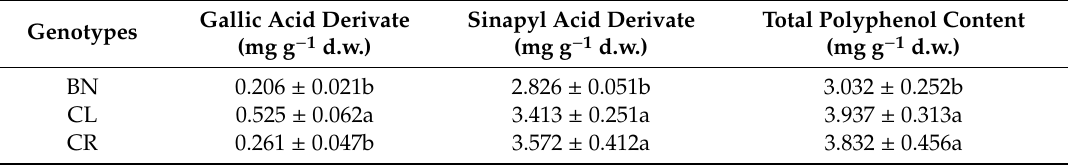
Table 5. Polyphenol content in seeds of BN, CR and CL.